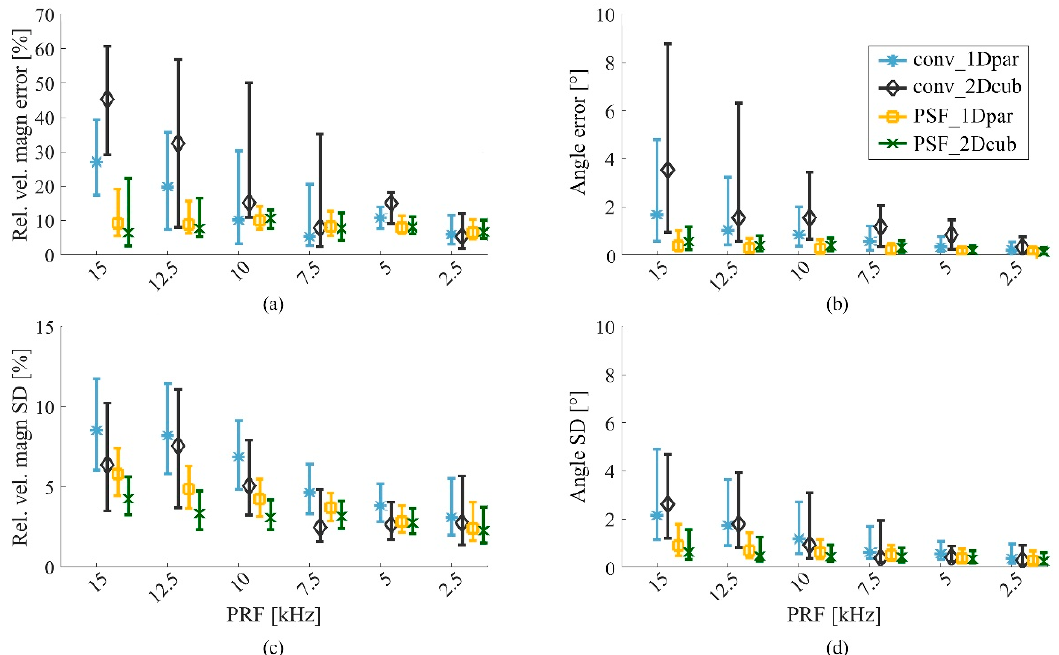
Figure 4. Median and interquartile ranges of the absolute bias ( a ) and standard deviation (SD) ( c ) for the velocity magnitude, and the absolute bias ( b ) and SD ( d ) for the velocity angle as a function of PRF. Statistics were calculated taking into account all beam-to-flow angles.